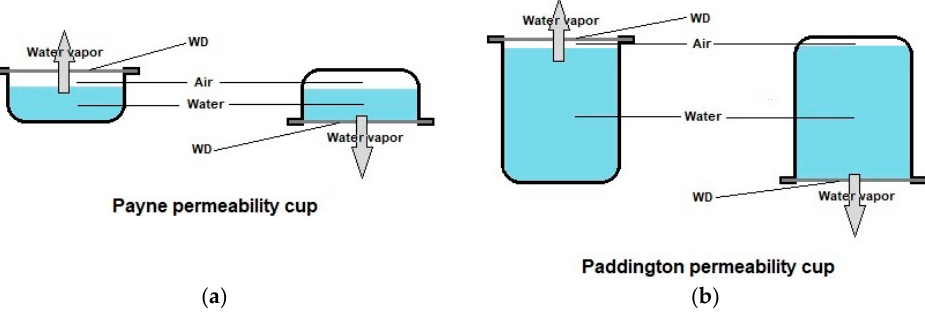
Figure 5. Schematic representation of the permeability cells specified for the measurement of moisture